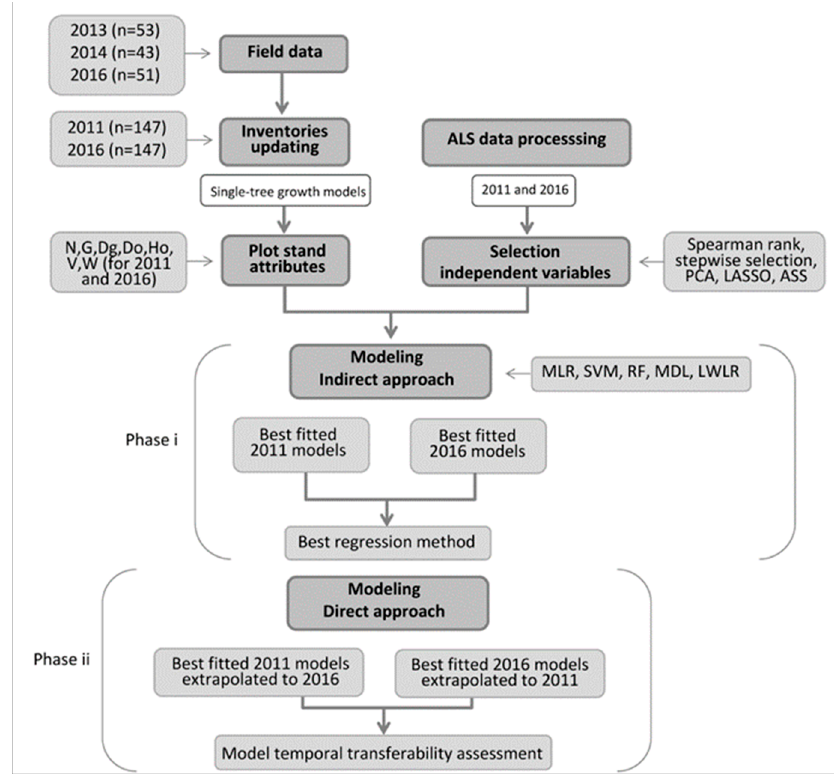
Figure 2. Methodology for forest stand attributes estimation using indirect and direct approaches.